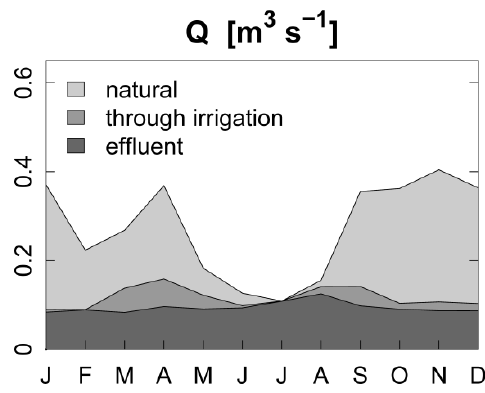
Figure 7. Long-term average (2002–2011) seasonal dynamics of total water inflow to the Mar